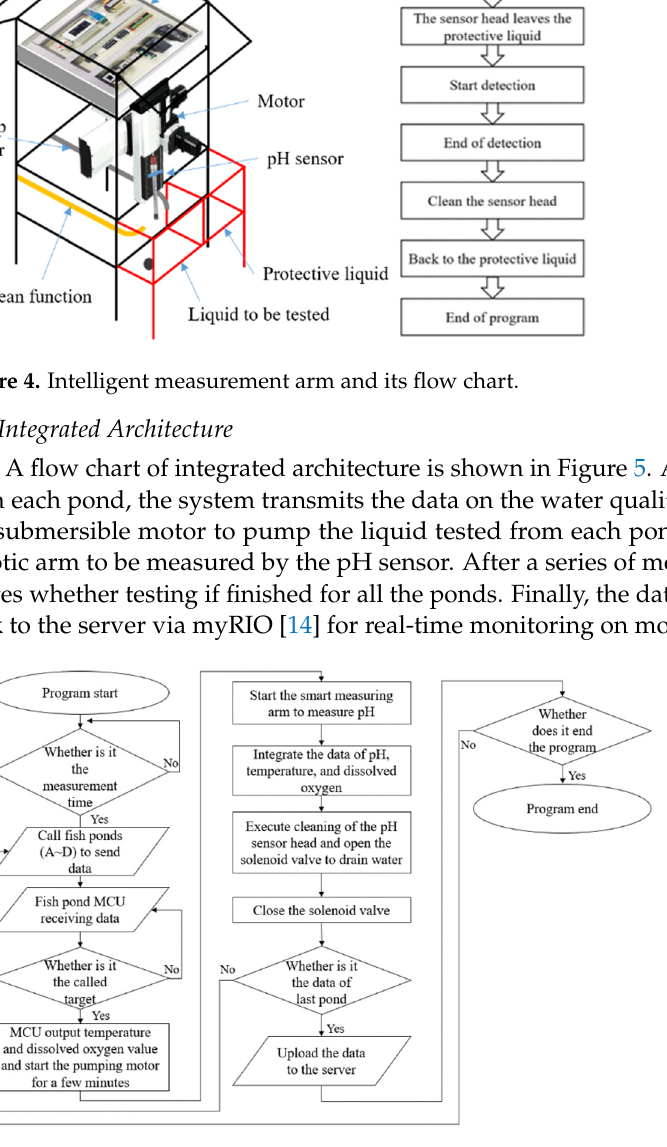
Figure 5. The flow chart of integrated architecture.